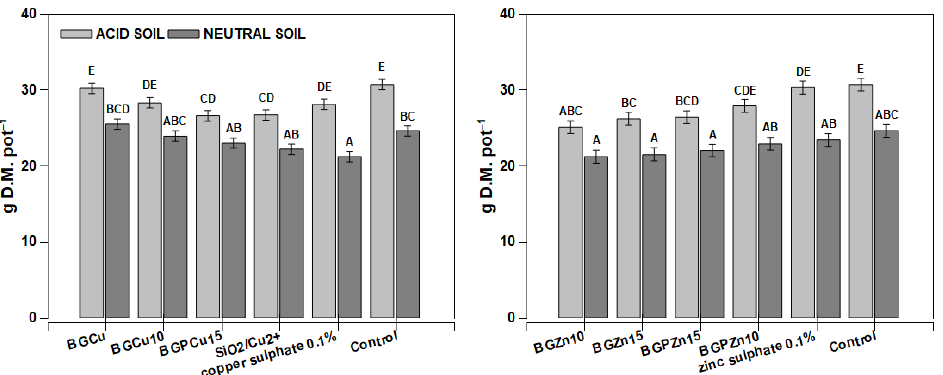
Figure 6. Yields of maize (Zea mays) after foliar application of different fertilizer formulations. Grey bars for acid, dark grey for neutral soil. Bars marked with the same letters represent homogenous groups after Tukey’s test at p < 0.05 and error bars represent standard error (n = 4). Maize grown on acidic soil had a low copper content per whole plant (Figure 7A,C).